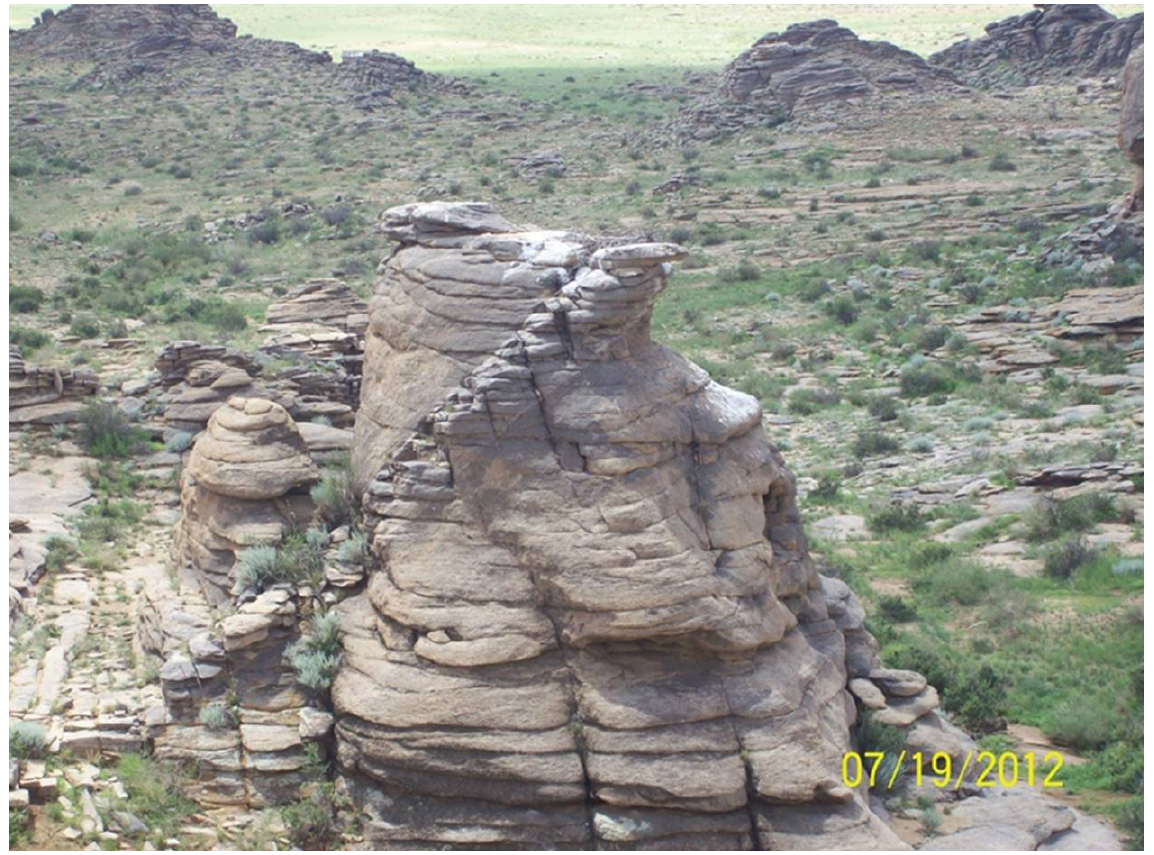
Figure 3. Typical granitic outcrops characteristic of the northern Ikh Nart